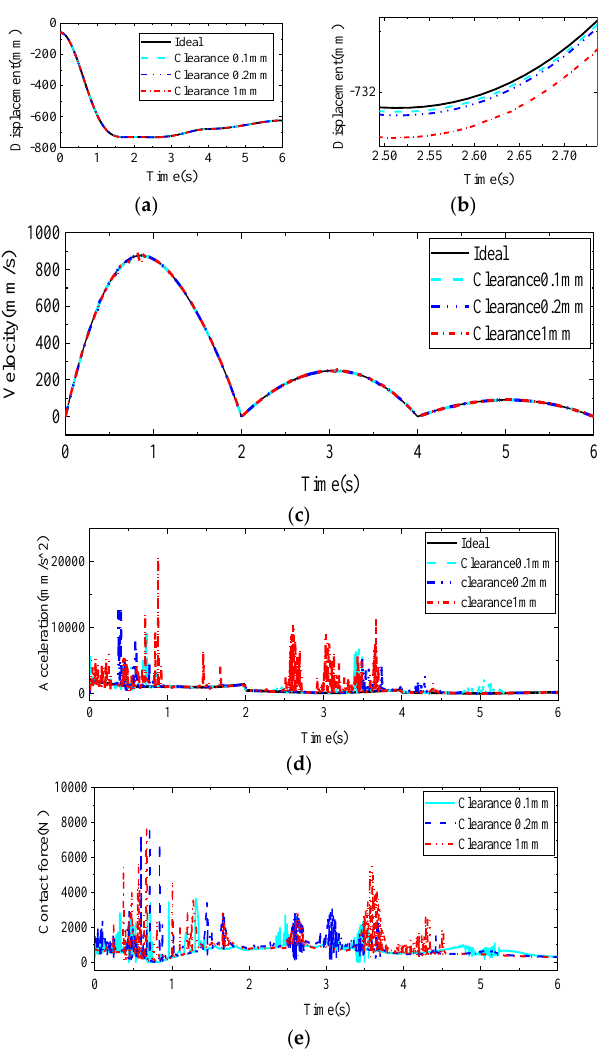
Figure 7. Change curve of influence of clearance size on motion parameters of mechanism: ( a ) Displacement curve; ( b ) Partial enlargement of displacement curve; ( c ) End velocity variation curve; ( d ) End acceleration variation curve; ( e ) Joint contact force variation curve.